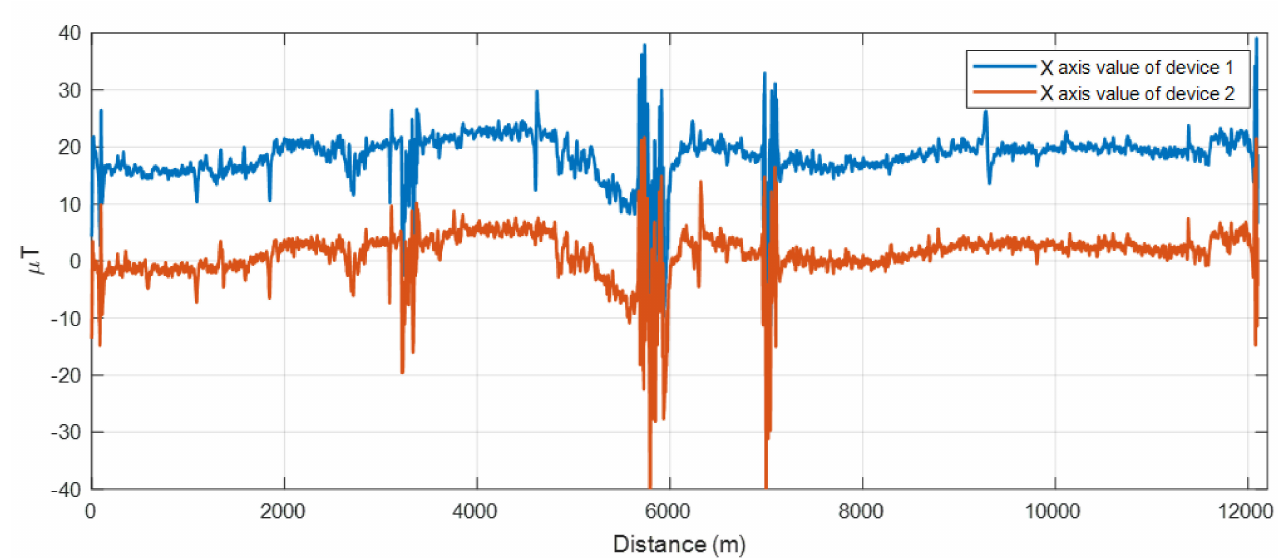
Figure 6. Magnetic field values of two distinct smartphones in the tunnel. As the vehicle position before entering the tunnel is known from the GNSS, the magnetic sensor of the user smartphone can be calibrated based on the corresponding DB value. The magnetic sensor values recorded using the two smartphones in indoor conditions are presented in Figure 7, wherein the blue and red lines represent the y axis values of the magnetic sensor of the first and second smartphones, respectively. The experimenter walked with the two smartphones side-by-side. The experimenter held two smartphones in the same direction and walked up to 1000 samples. Thereafter, the experimenter altered the attitude of the second smartphone and walked further. Up to 1000 samples, the two smartphones exhibited similar patterns due to their identical orientation. However, the absolute values of the magnetic sensors varied due to the bias of the two magnetic sensors. Subsequently, the y axis value varied as the axis of the second smartphone was altered after 1000 samples. The orange line denotes the results of altering the axis of the second smartphone with respect to the DB frame with the sensor